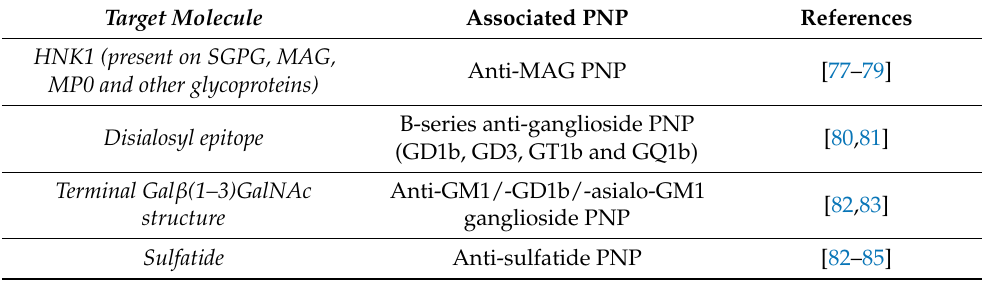
Table 1. Possible antigens for M-proteins in the peripheral nerve. HNK1: human natural killer 1 carbohydrate epitope. SGPG: sulfated glucuronyl paragloboside. MAG: myelin-associated glycopro- tein. MP0: myelin protein zero. Disialosyl epitope: specifically, the NeuAc( α 2-8)NeuAc( α 2-3)-Gal configuration. Sulfatide: galactosylceramide-3- O -sulfate. Target Molecule Associated